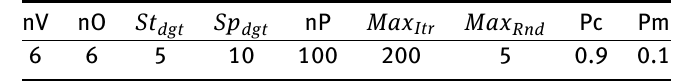
Table 37: VSSCGA Settings for Neurophysiology Application (case 2)